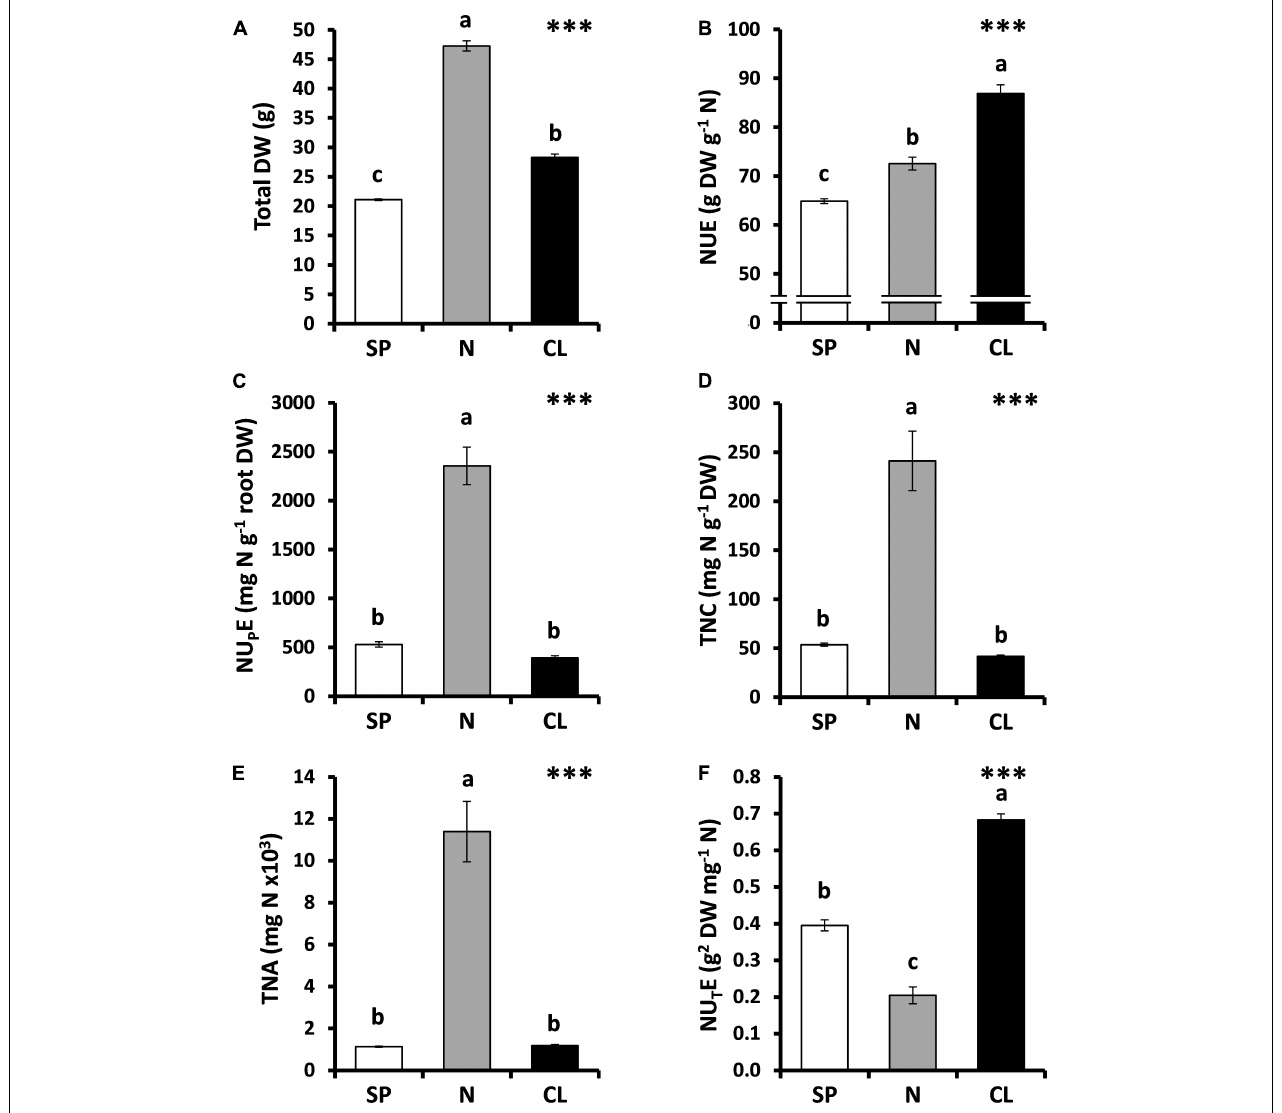
FIGURE 1 | Effect of Cl − nutrition on tobacco biomass and nitrogen use efficiency (NUE) parameters. Treatments consisted of the application of the basal nutrient solution supplemented with 5 mM Cl − (CL), 5 mM NO 3 − (N), or the SO 42 − + PO 43 − (SP) salt mixture, containing the same cationic balance in all treatments. (A) Total dry weight (DW). (B) NUE. (C) Nitrogen-uptake efficiency (NU P E). (D) Total nitrogen content (TNC). (E) Total nitrogen assimilated (TNA). (F) Nitrogen-utilization efficiency (NU T E). Mean values ± SE, n = 4-6. Levels of significance: ∗∗∗ P ≤ 0.001; and “homogeneous group” statistics was